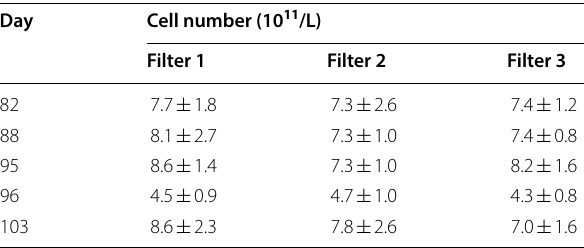
Table 1 Total cell count per liter volume of the three BAC filters